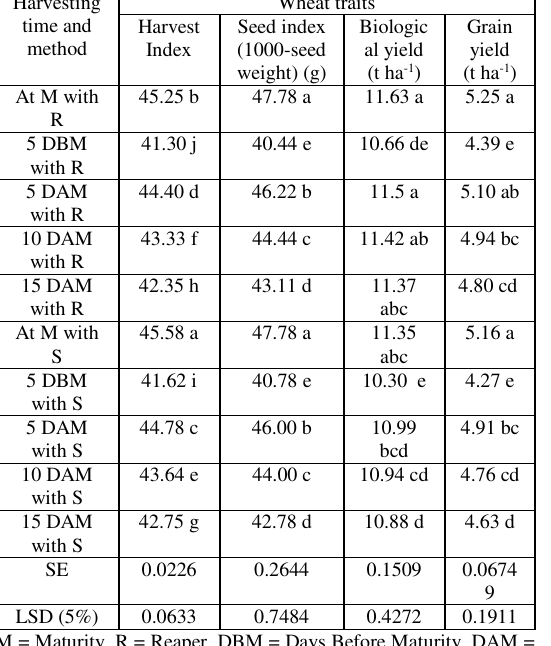
Table 1: Effect of harvesting time and methods on some agronomical and yield traits of bread wheat (Mean data of two years 2008-09 & 2009-10)